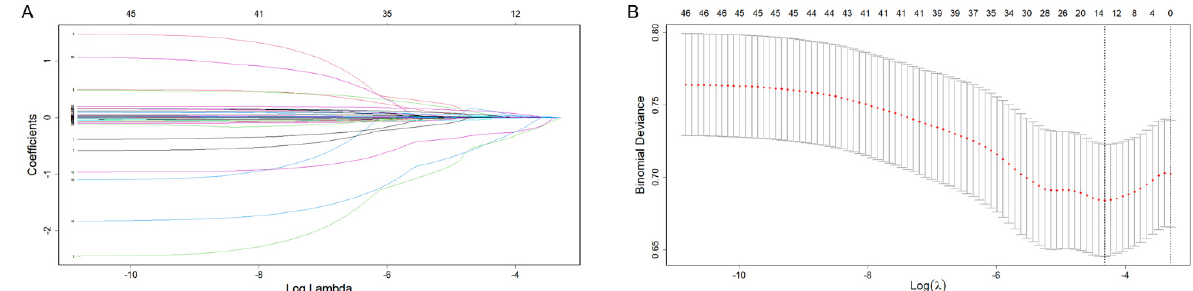
Figure 2. The process of variable selection by the LASSO binary logistic regression model. A coefficient profile plot was produced against the log(lambda) sequence ( A ). Thirteen variables with non-zero coefficients were selected by optimal lambda. By verifying the optimal lambda in the LASSO model, the partial likelihood deviance (binomial deviance) curve was plotted. Different colors represent the different variables. ( B ), and dotted vertical lines were drawn based on minimum lambda and standard error criteria.